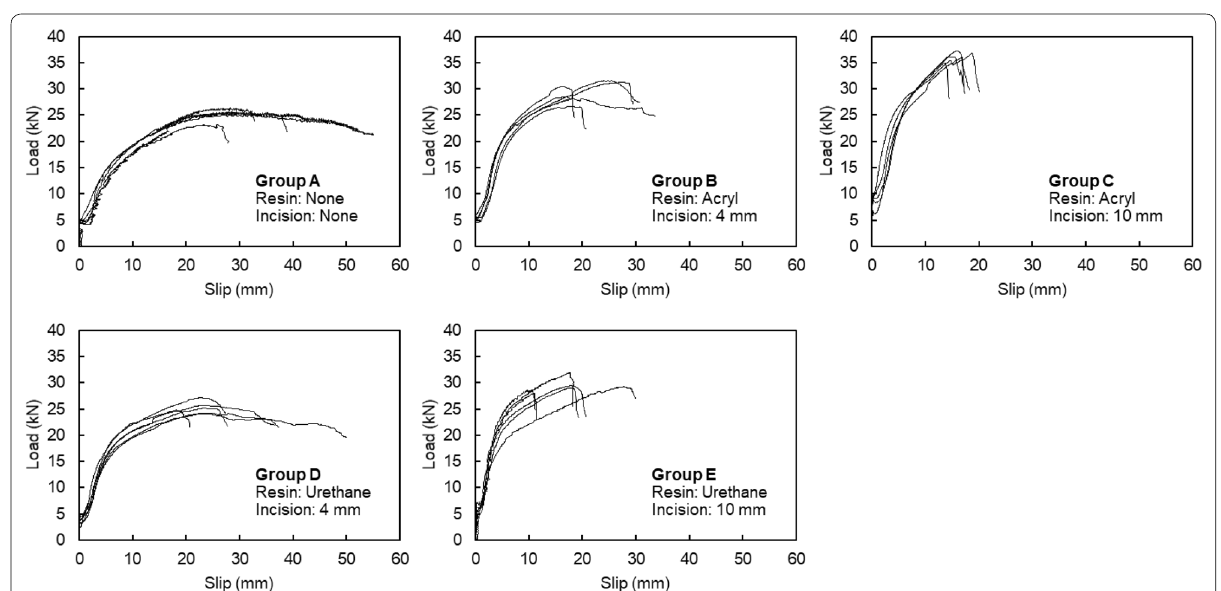
Fig. 7 Load–slip relationships of groups loaded parallel to the